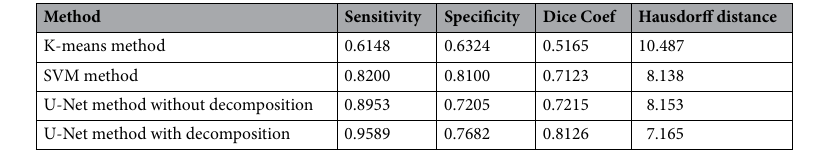
Table 1. Performance metrics for segmentation with dermnet images.